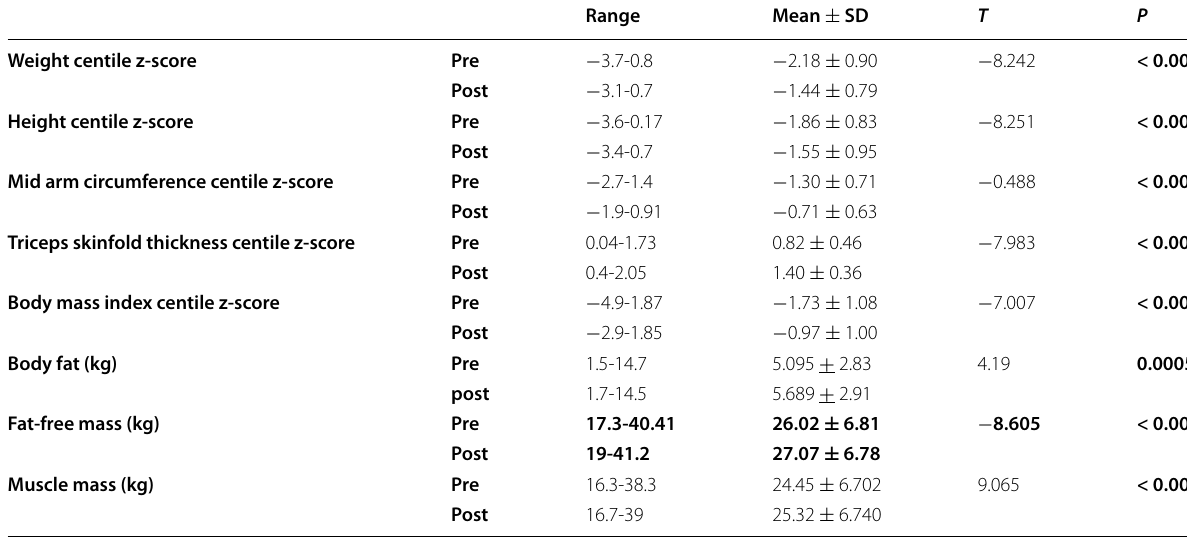
Nutritional rehabilitation significantly improved patient anthropometry and body composition